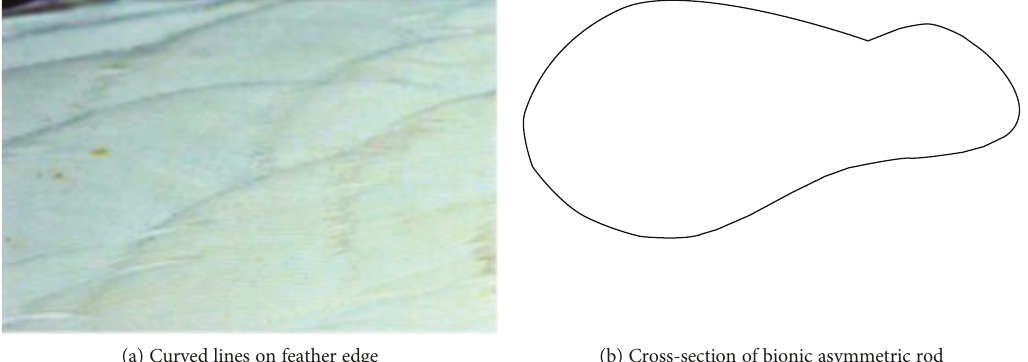
Figure 1: Asymmetric rod imitating feather edge of carrier pigeon.